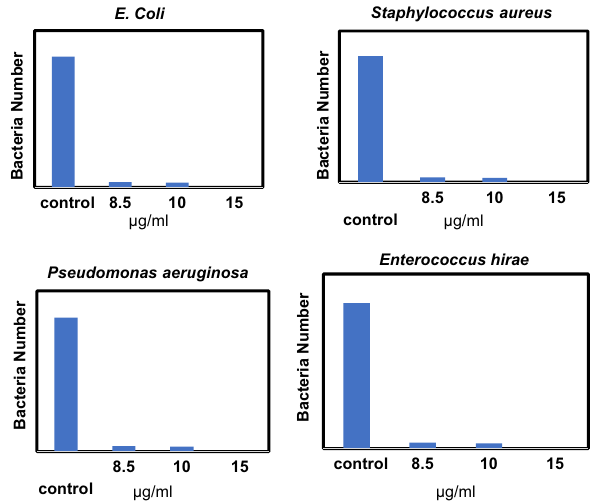
Figure 7. Effect of synthesized nanoparticles on E. coli , Staphylococcus aureus , Enterococcus hira , and Pseudomonas aeruginosa , in different concentrations (the concentrations of 8.5, 10 and, 15 µg/mL are related to Ag nanoparticles and the concentrations of ZnO NPs is 50 µg/mL for all).